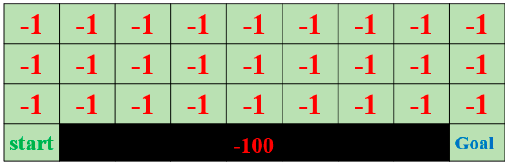
Figure 15. Example in the grid-world environment.